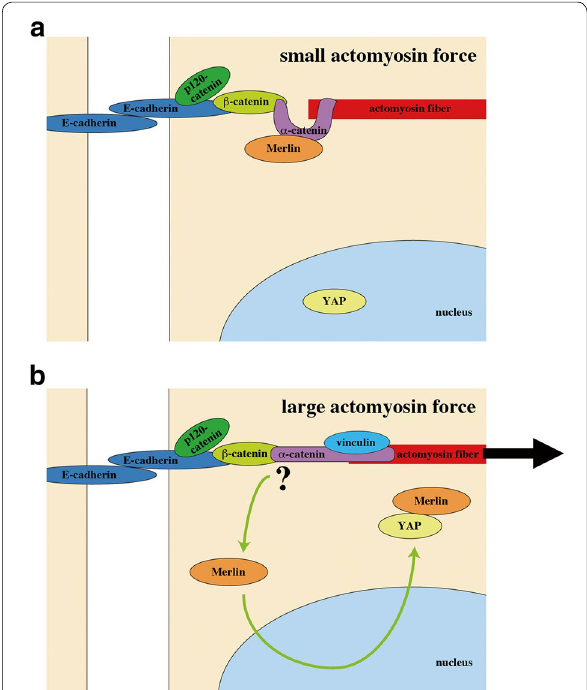
Fig. 5 A hypothetical model for YAP/TAZ regulation by tension at AJs. a Low tension AJ with small actomyosin force. Under this condition, Merlin localizes to AJs through its binding with α-catenin. b High tension AJ with large actomyosin force. AJ tension causes dissociation of Merlin from AJs, which may be associated with a force-induced conformational change of α-catenin. Released Merlin enters the nucleus, binds nuclear YAP, and then exports it from the nucleus with the aid of NESs in